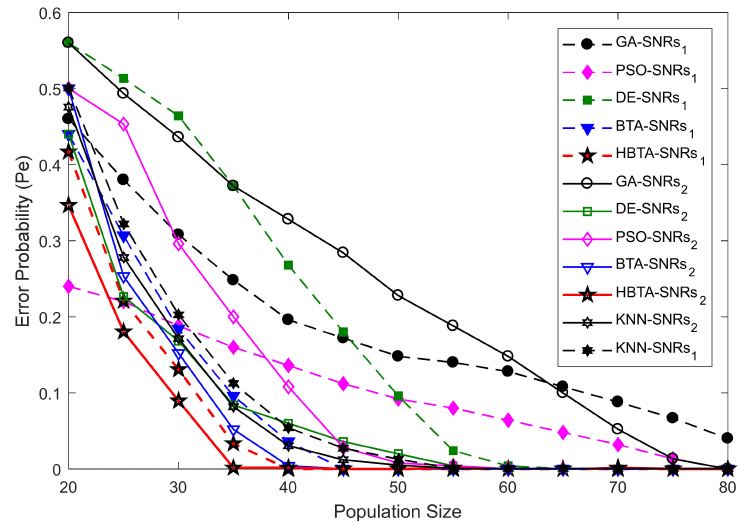
Figure 8. Error probability vs. population size in the presence of AN-ANC users with SNRs 1 ( − 9.5 dB) and SNRs 2 ( − 0.5